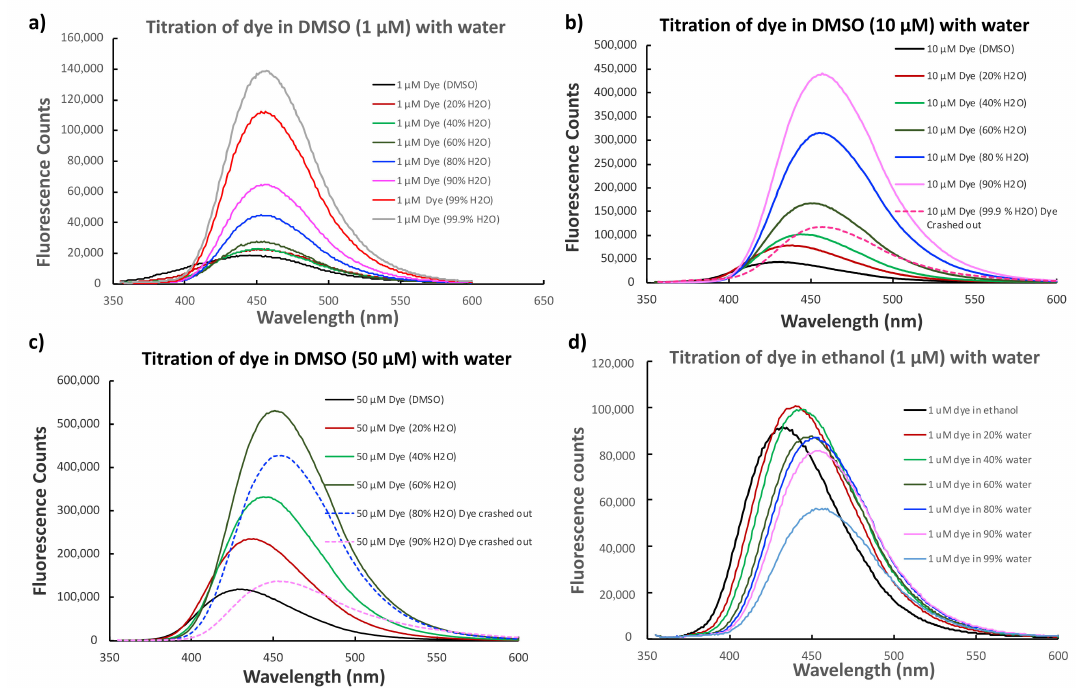
Figure 2. Changes in fluorescence intensity of 4-phenyl-1,8-naphthalimide in DMSO and ethanol upon addition of water. ( a ). 1 µ M dye in DMSO, ( b ). 10 µ M dye in DMSO, ( c ). 50 µ M dye in DMSO, and ( d ). 1 µ M dye in